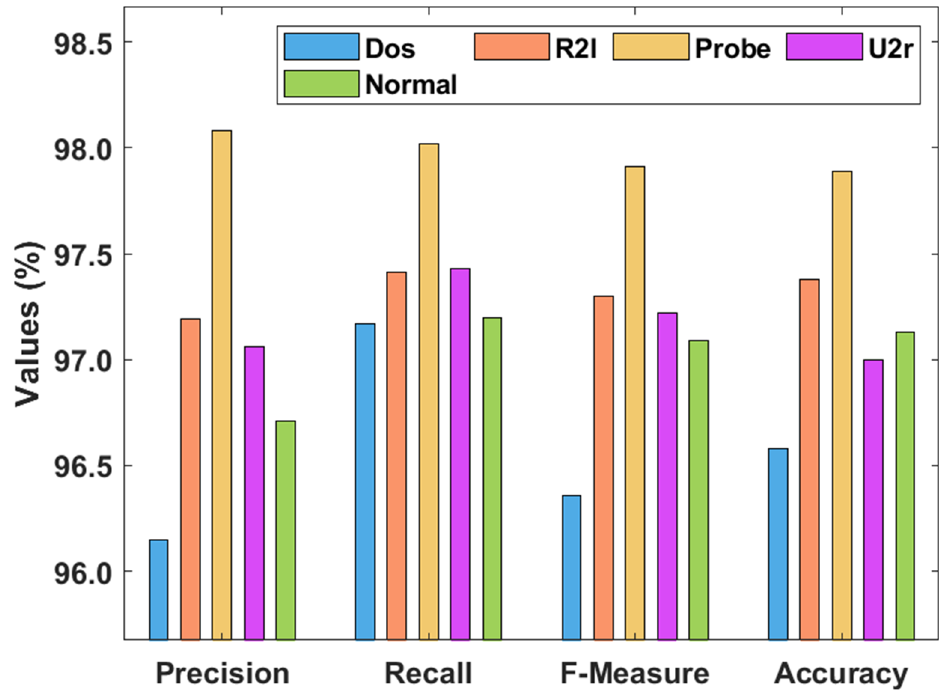
Figure 9. The Classifier results analysis of the RNN-LSTM model.